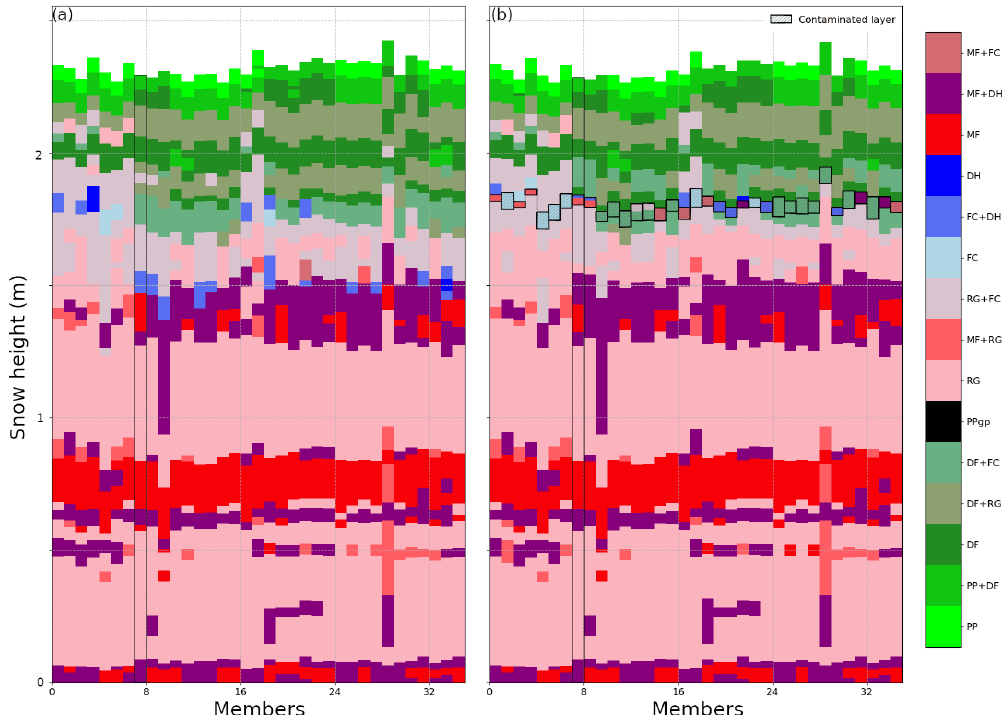
Figure 4. Snow profiles of the 35 members of the no-dust simulation (a) and dust simulation (b) for the northern slope on 18 March 2018 at noon. The member represented in Fig. 2 is surrounded by a black rectangle, and the contaminated layers for each member are hatched in (b) . Snow shape names follow the international snow grain shape classification (Fierz et al., 2009).